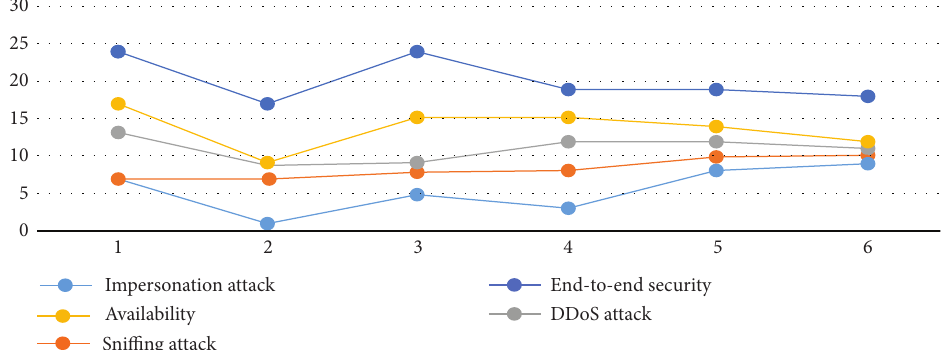
Figure 4: Dynamic key management schemes versus schemes for TCP data.